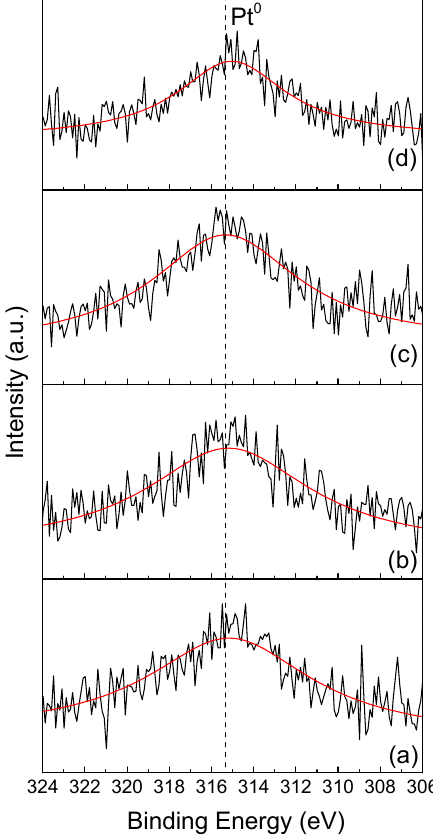
Figure 7. X-ray photoelectron spectroscopy (XPS) Pt 4f curves of catalysts. ( a ) PtSn-C, ( b ) PtSn-B, ( c ) PtSn-B-HCl5, and ( d ) PtSn-B-HCl35.